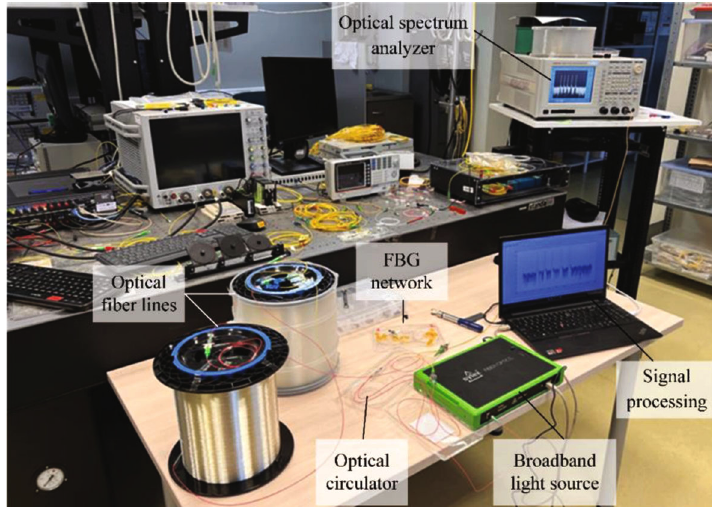
Figure 14: Experimental validation of the developed simulation model in laboratory environment.